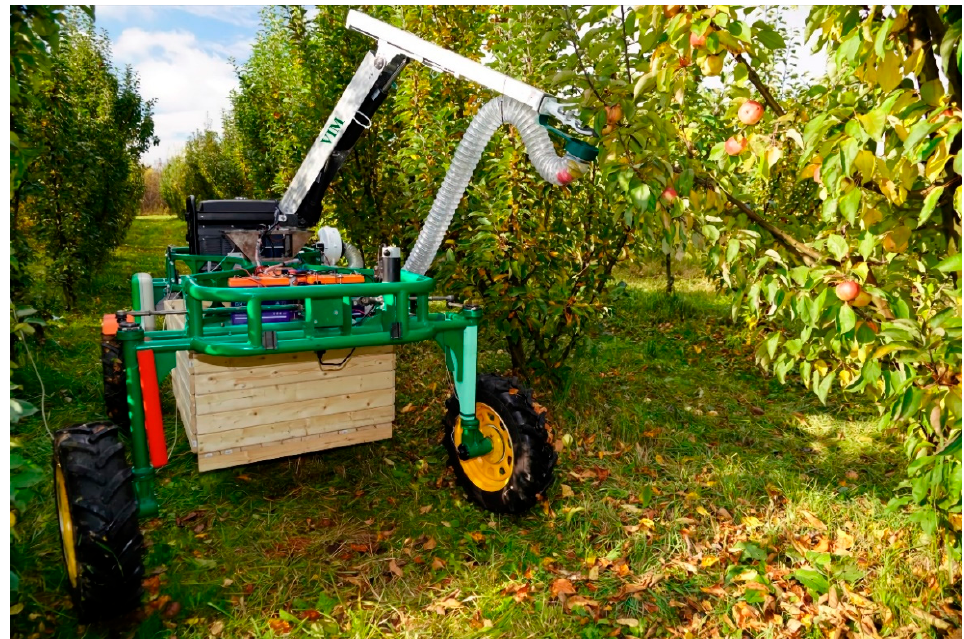
Figure 2. Wheeled robotic platform with a robotic device for fruit removal.